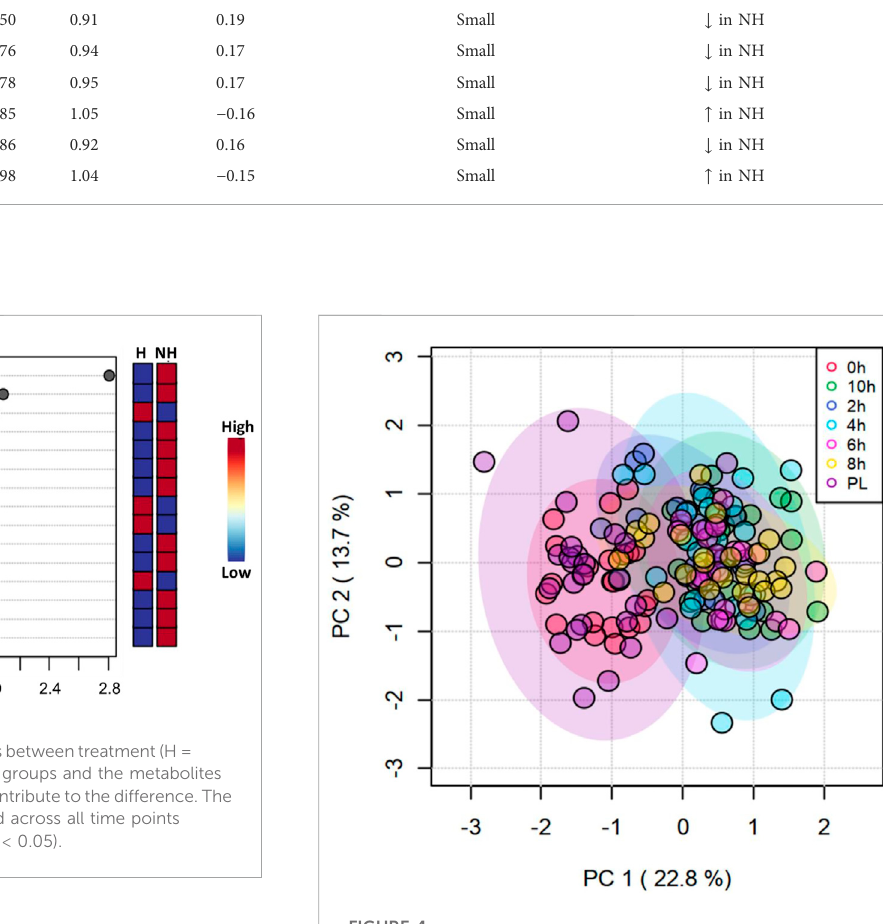
FIGURE 4 Principal Component Analysis (PCA) plot of principal components 1 and 2 of transportation time for